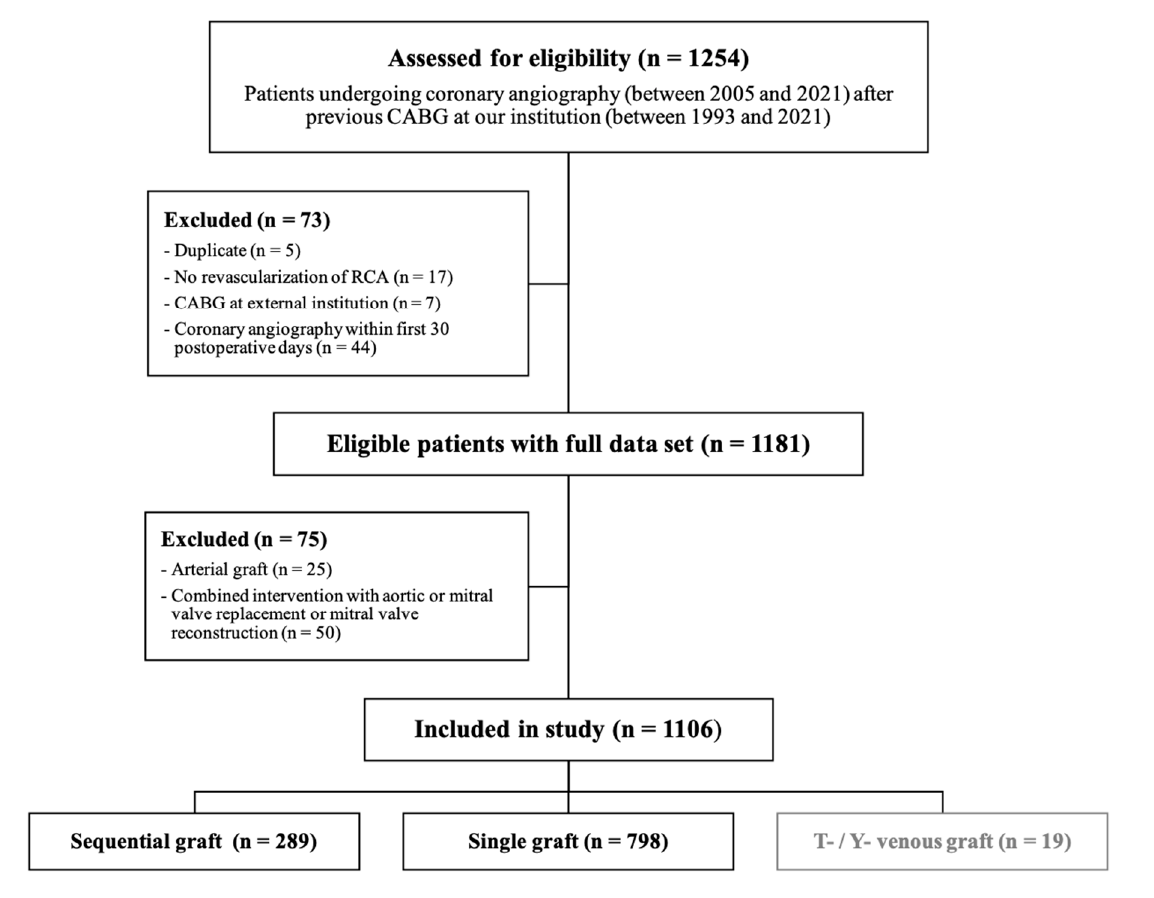
Figure 1. CONSORT